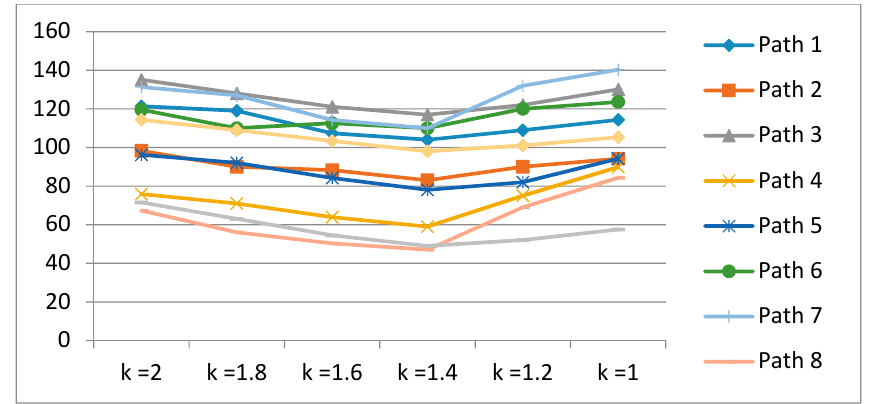
Figure 11. Error charts for k values in large test area (unit of y -axis: cm).